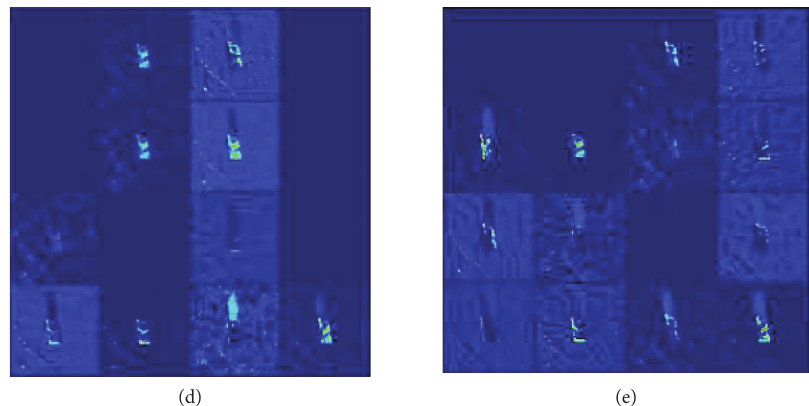
Figure 11: (a) The basic network. (b) Basic network using enhanced-shape data set. (c) SoftPool is used on the basic network, where enhanced-shape dataset is inputted. (d) SoftPool and SE module are used on the basic network, where enhanced-shape data set is inputted. (e) SoftPool and enhanced SE module are used on the basic network, where enhanced-shape data set is inputted.